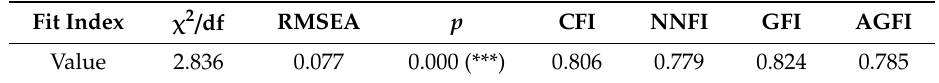
Table 4. The summary of model fit indices.